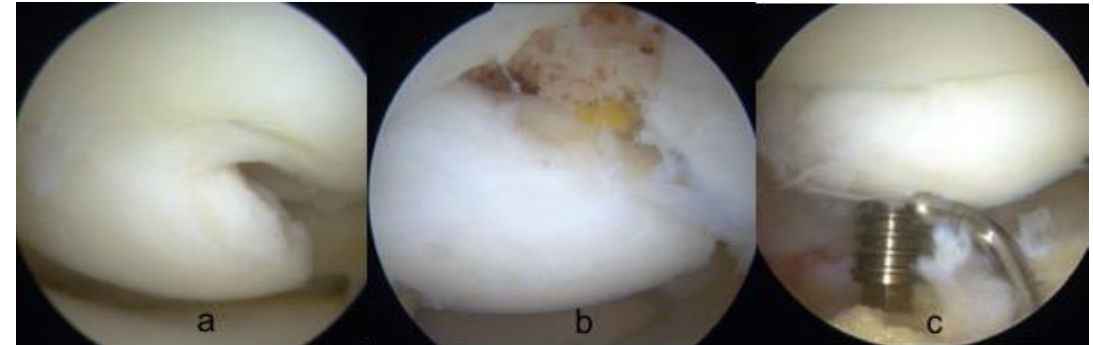
Figure 4. arthroscopic fixation of grade IV OCD. ( a ) The fragment was lifted while keeping a chondral-flap attachment; ( b ) cancellous bone graft was used to fill the bone defect; ( c ) fixation with a cannulated screw was achieved paying attention to direct the screw perpendicular to the lesion.